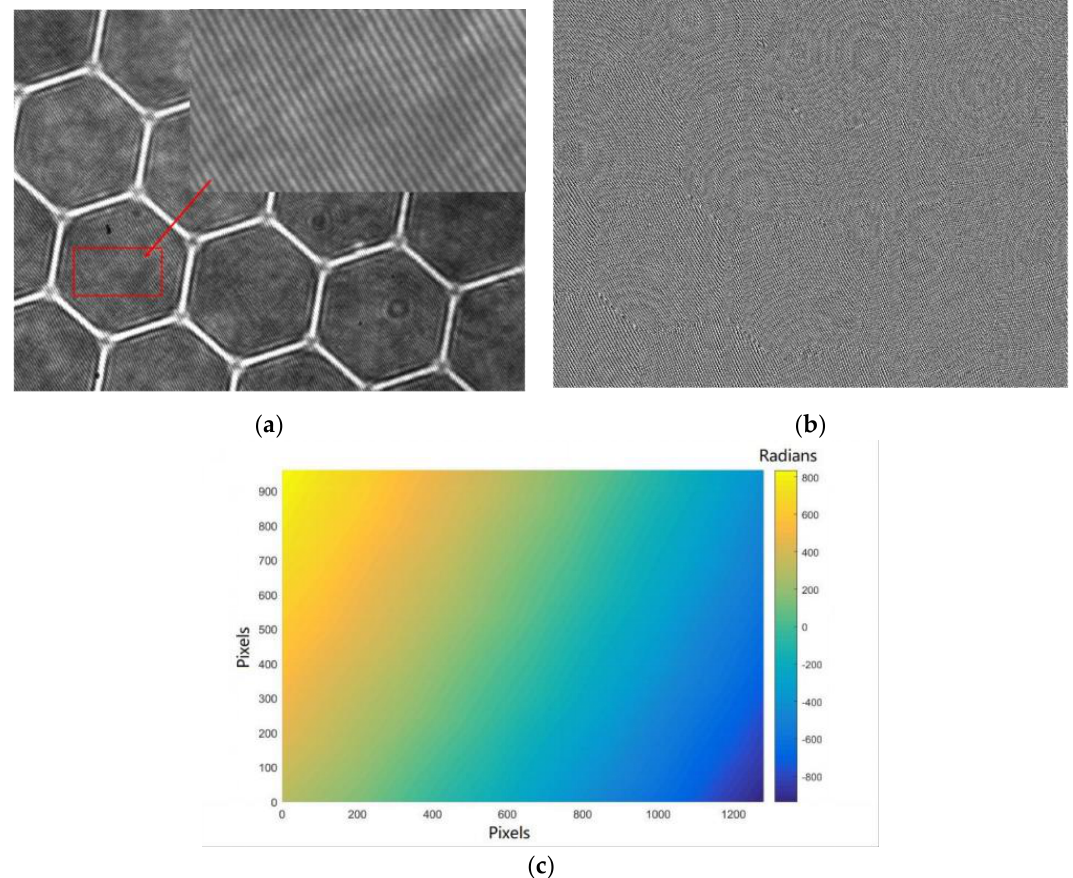
Figure 5. Reconstructed phase data for the micro-lens array, including ( a ) the hologram, ( b ) the wrapped phase map, and ( c ) the unwrapped phase map.